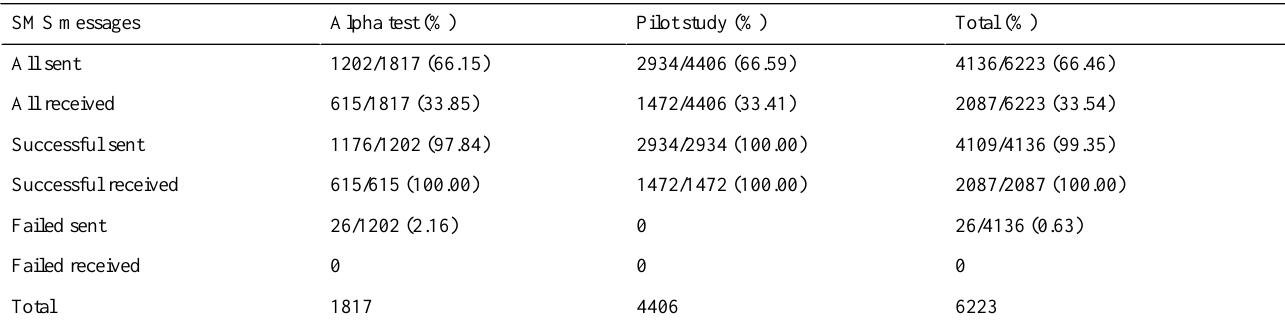
Table 3. Comparison of the alpha test and pilot study SMS